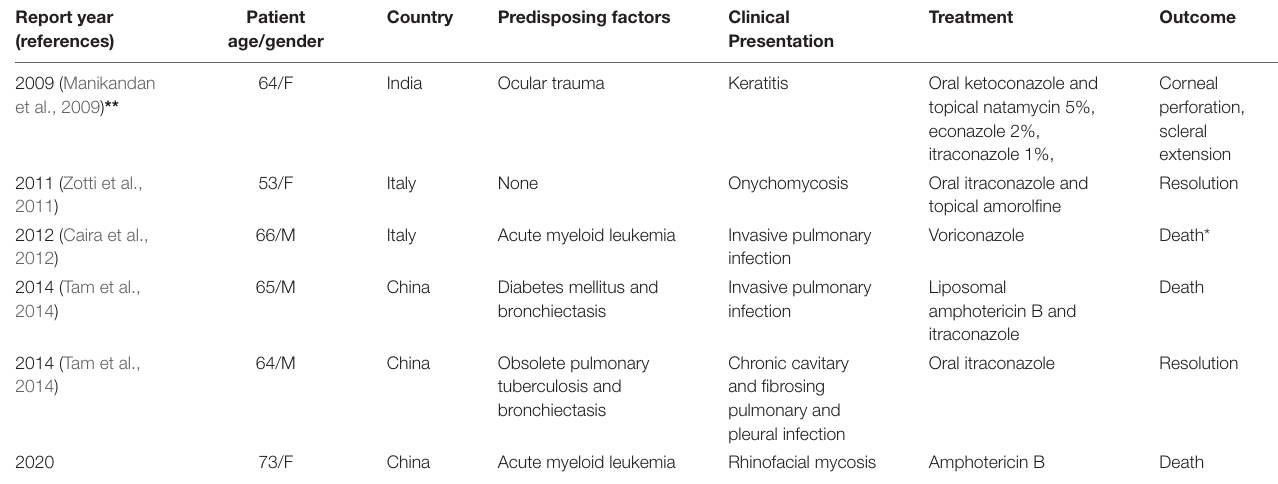
TABLE 2 | Cases of A. nomiae infection of humans reported in the